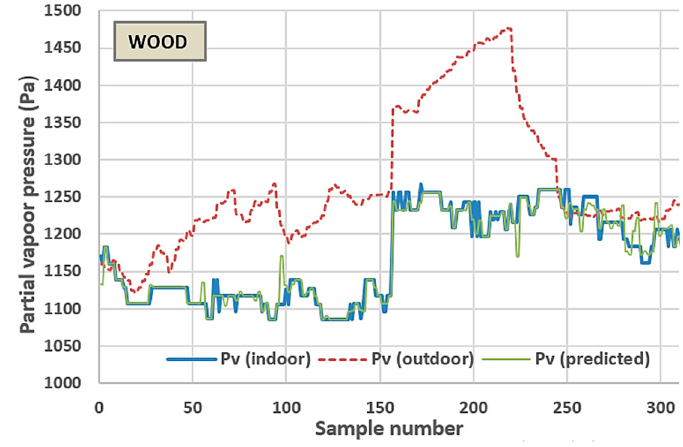
Figure 3. Partial vapour in office buildings using paper as an internal covering material.